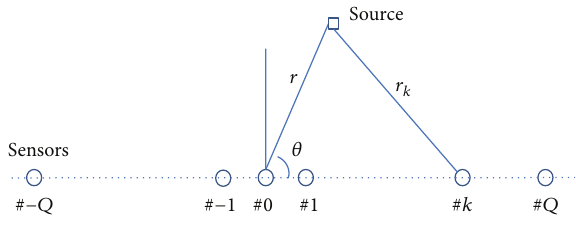
Figure 1: The geometry for near-field source